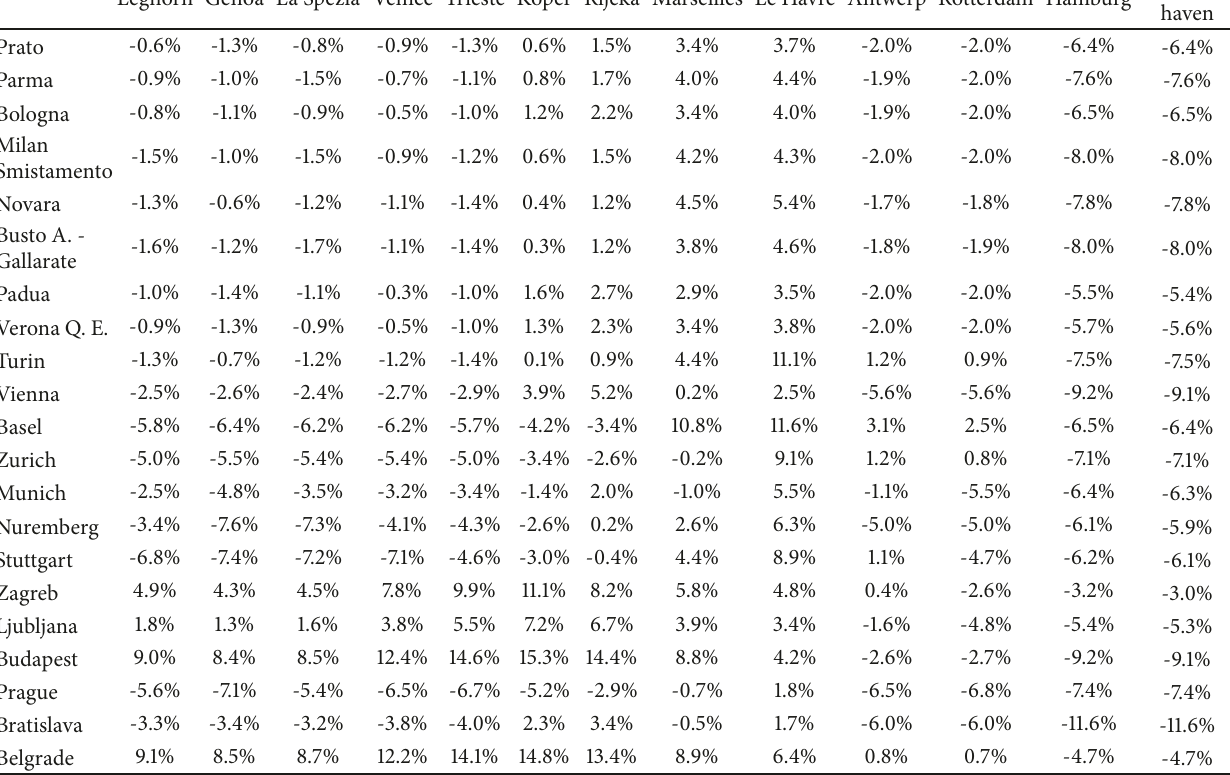
Table 10: Differences, in percentage, of monetary costs, between monetary costs of the second sensitivity scenario and monetary costs of the current scenario (the current scenario is taken as